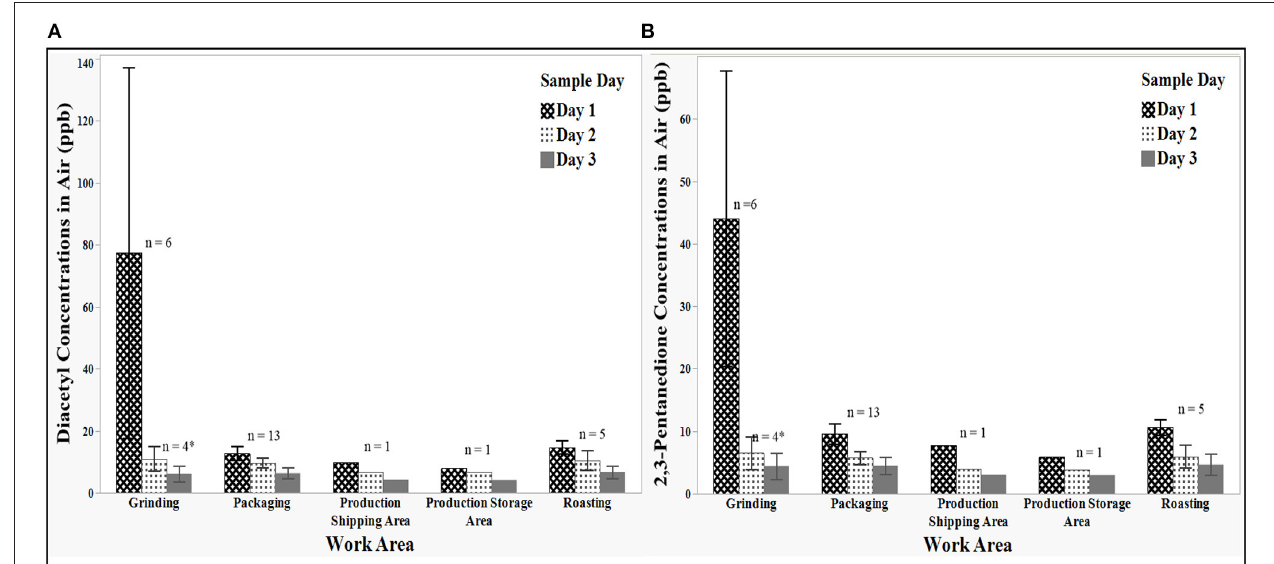
FIGURE 3 | Mean concentrations of diacetyl (A) and 2,3-pentanedione (B) by sample day and work area. Error bars represent the standard deviation. *After enclosure, the grinding mean concentration on Days 2 and 3 did not include the sample inside the two grinding